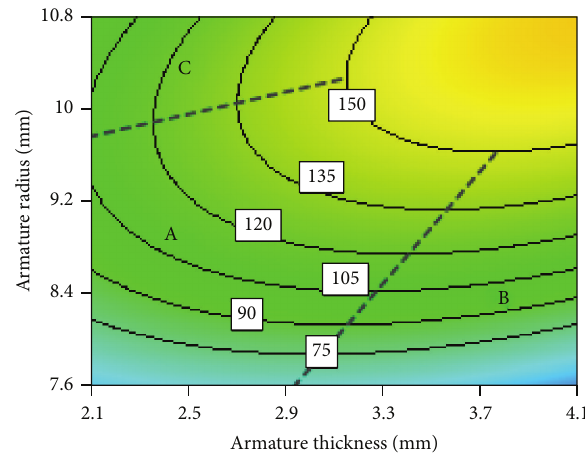
Figure 20: Interaction of coil turns and side pole radius. Figure 21: Interaction of armature thickness and armature radius.